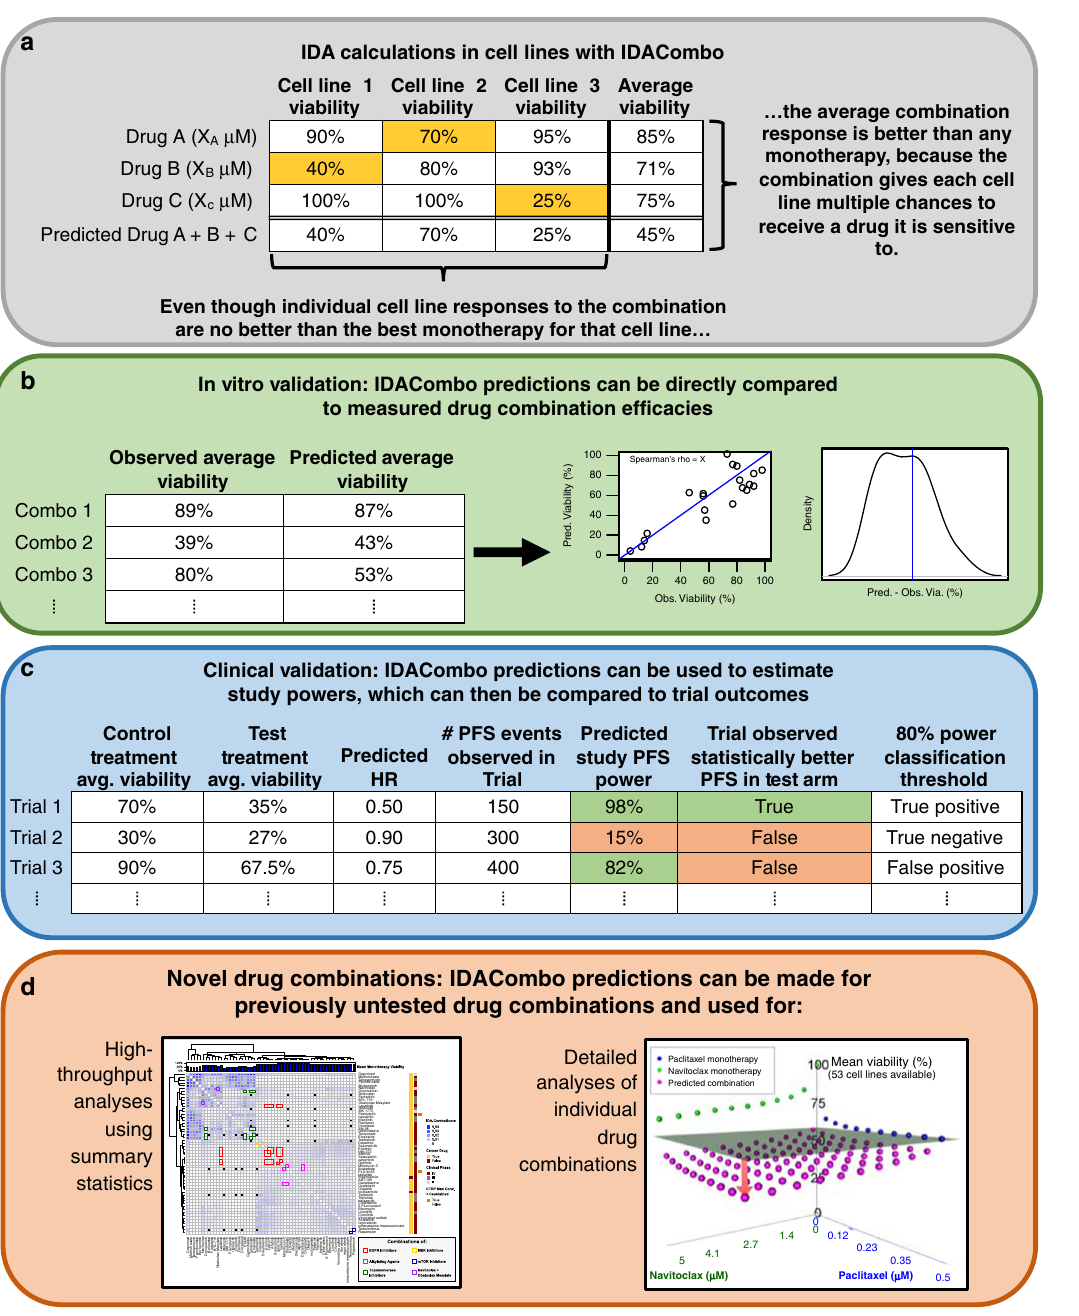
Fig. 1 IDACombo allows drug combination ef fi cacy predictions to be made using monotherapy cell line screening data, and these predictions can be validated against measured ef fi cacies or used to identify novel ef fi cacious drug combinations. a Example calculations demonstrating how IDACombo predicts drug combination ef fi cacies based on IDA. In this example, three cell lines (1 – 3) with measured ef fi cacies for three monotherapies (A – C) at their selected concentrations are used to predict the ef fi cacy of the combination of drugs A + B + C. Highlighted cells indicate the best monotherapy for that cell line (i.e. provides greatest reduction in viability). b Strategy for validating IDACombo ef fi cacy predictions using in vitro measurements of ef fi cacy. Measured and predicted average ef fi cacies for each treatment can be directly compared by calculating their correlation and calculating prediction errors. c Strategy for validating IDACombo ef fi cacy predictions using published clinical trial results. Combination ef fi cacies which have been predicted using cell line data are used to predict study HRs, and these predicted HRs are used, along with the number of events observed in each clinical trial, to predict study powers. Predicted HRs can be compared to reported HRs, and a power threshold (80%) can be set to classify trials as likely or unlikely to detect a signi fi cant improvement in a trial outcome (i.e. PFS), which can then be compared to observed trial outcomes. d Analysis techniques available for using IDACombo predictions to identify novel ef fi cacious drug combinations. High-throughput analyses using summary statistics can be used to compare ef fi cacy predictions for many drug combinations at once, or detailed analyses can be used to explore the ef fi cacy of a single drug combination at varying concentrations of each drug in the